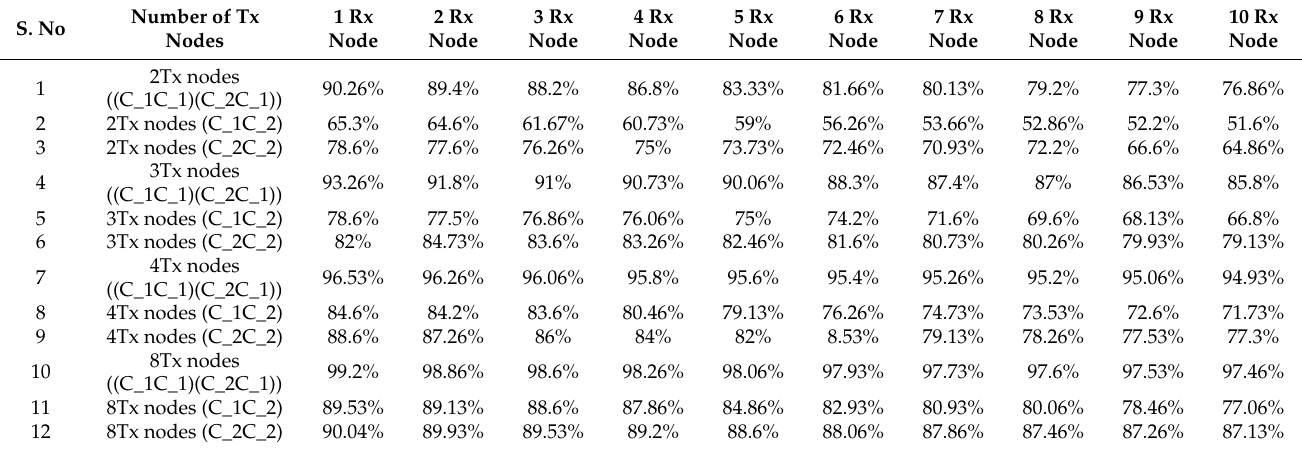
Table 2. Comparative analysis of localization estimation